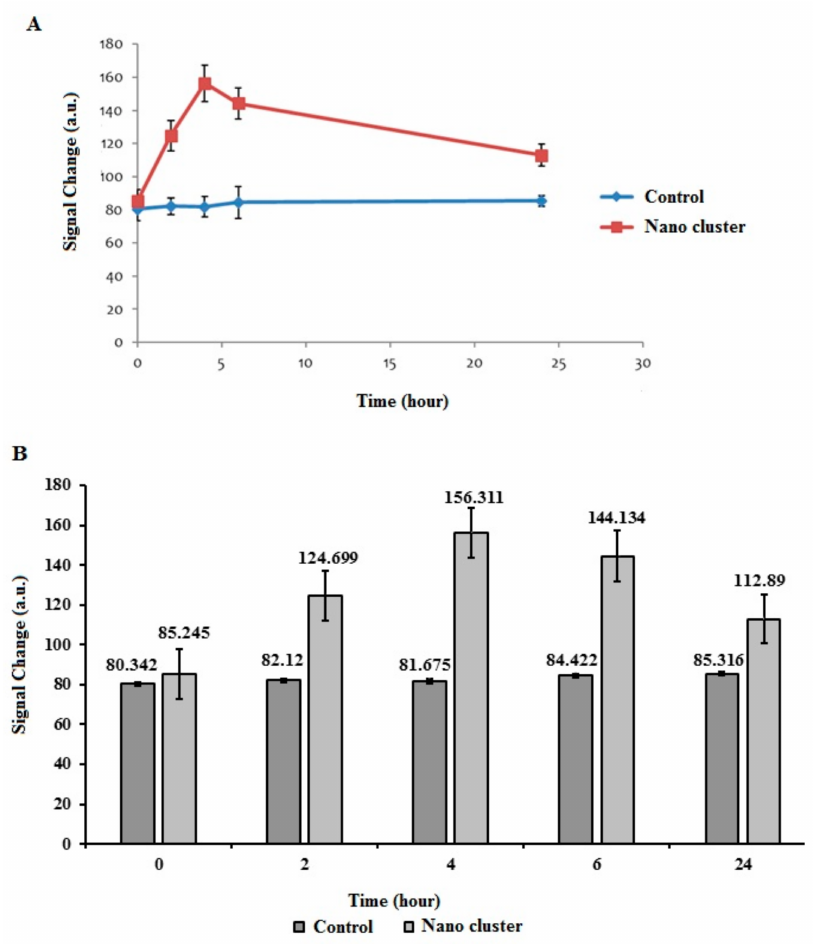
Figure 10. Both ( A , B ) show signal intensity changes over time in tumor-bearing and control